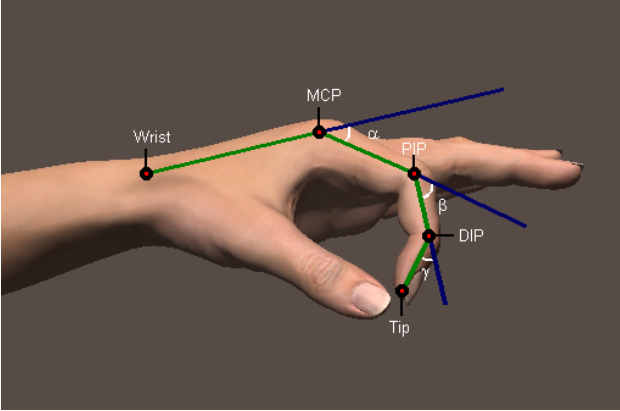
Figure 1. Position of the phalangeal